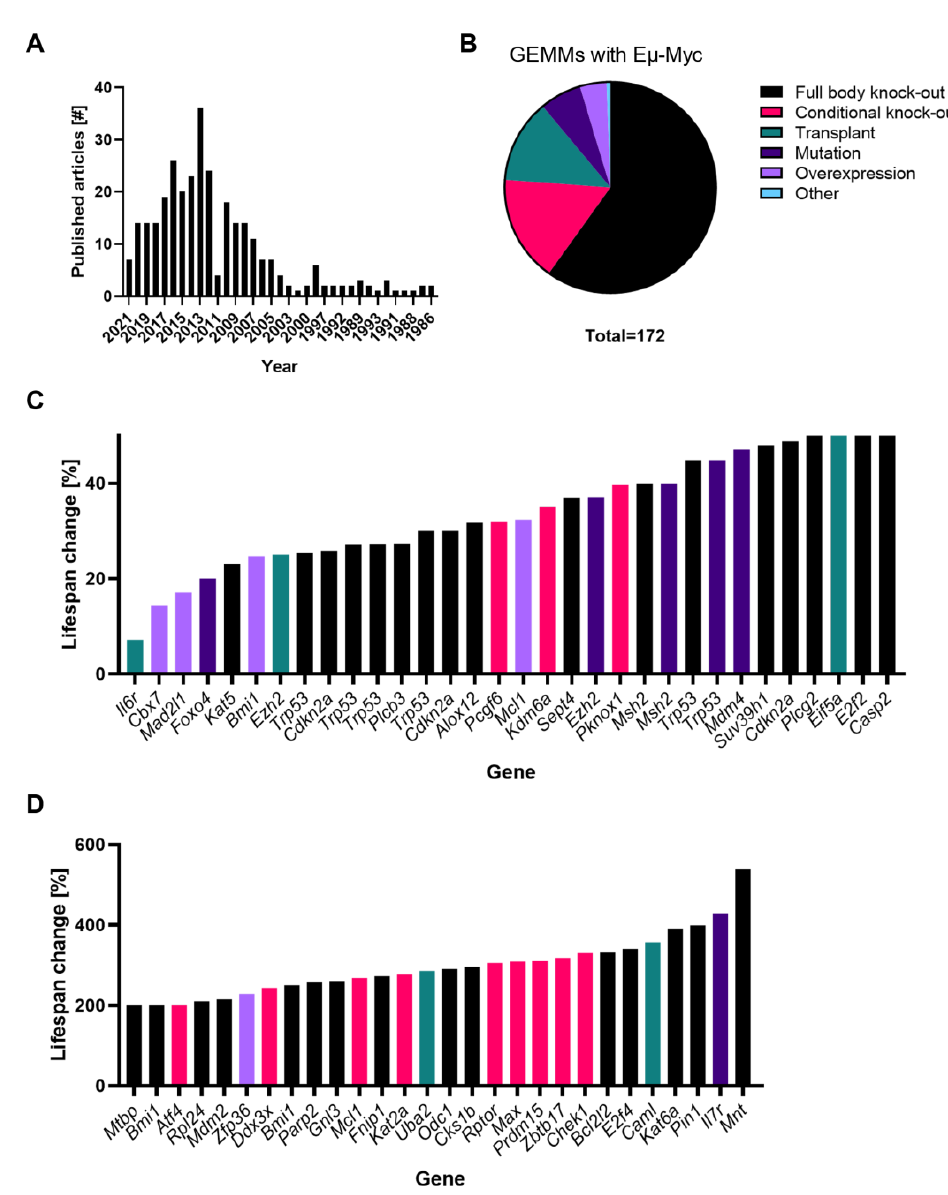
Figure 2. A meta-analysis of GEMMs of MYC-induced lymphoma. ( A ) Timeline of published articles using E µ -Myc transgenic mice found on Pubmed with search terms: “Emu-myc”, “E µ -myc”, or “Myc-induced lymphoma”. ( B ) Pie chart showing the type of mouse model used. Transplants do not fall under the term “GEMM”. ( C , D ) Ranked list of genes that decrease ( C ) or increase ( D ) survival, normalized to the control cohort for each study. Please refer to Table 1 for a complete list of genes.